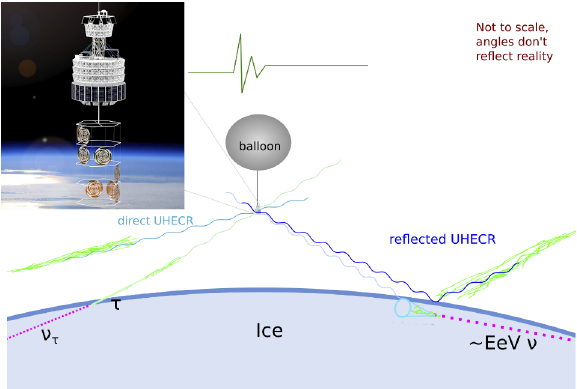
Figure 1. Diagram of PUEO’s observation scheme of cosmic rays and neutrinos, modi fi ed from original image from Cosmic Deaconu.